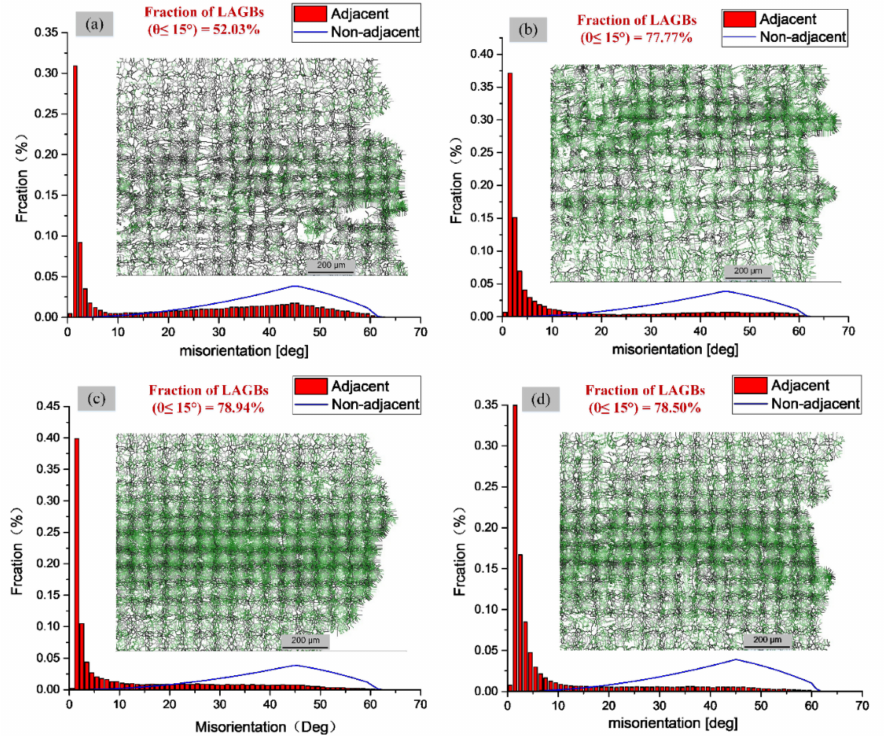
Figure 8. The misorientation distribution at various energy densities VED: ( a ) 37.5 J/mm 3 ; ( b ) 62.5 J/mm 3 ; ( c ) 81.6 J/mm 3 ; ( d ) 93.7 J/mm 3 . The results of the EBSD test are also reflected in the low-angle grain boundaries ( LAGBs , θ ≤ 15 ◦ ), Figure 8 depicts the grain boundary misorientation angle distribution at different energy densities, and the green lines indicate low-angle grain boundaries. As the volumetric energy density of VED increases from 37.5 J/mm 3 to 81.6 J/mm 3 , the LAGBs were evenly distributed in all samples, and their fraction increased from 52.03% to 78.94%. However, further increasing the energy density VED to 93.7 J/mm 3 , a decrease rather